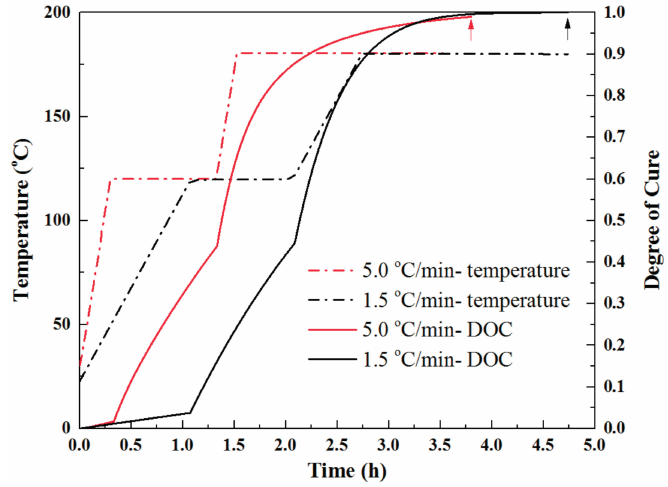
Figure 4. Degree of cure as a function of cure cycle time for fast and slow heating